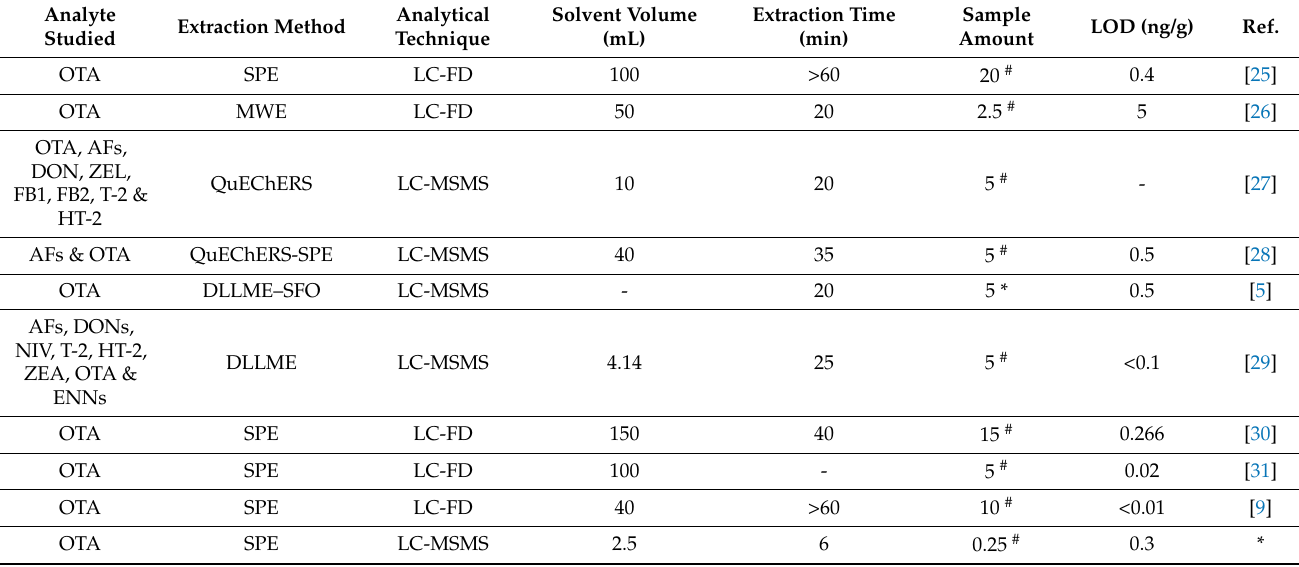
Table 2. Comparison of the developed method with previously reported